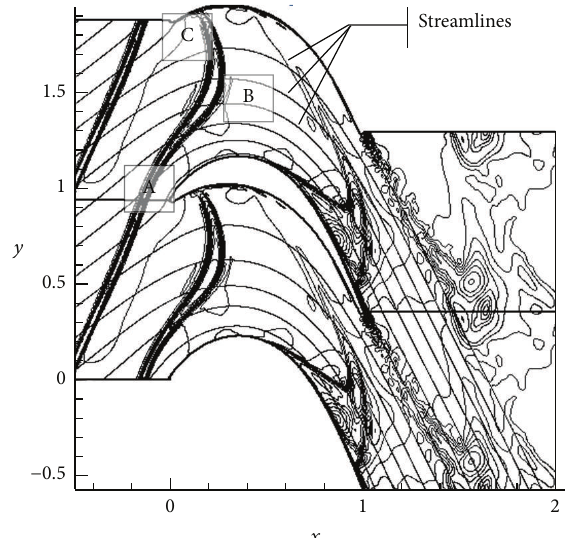
Figure 10: Phase-averaged streamlines and velocity defect isolines computed by the LES, Φ = 0.00 , Re = 1.48 × 10 5 .